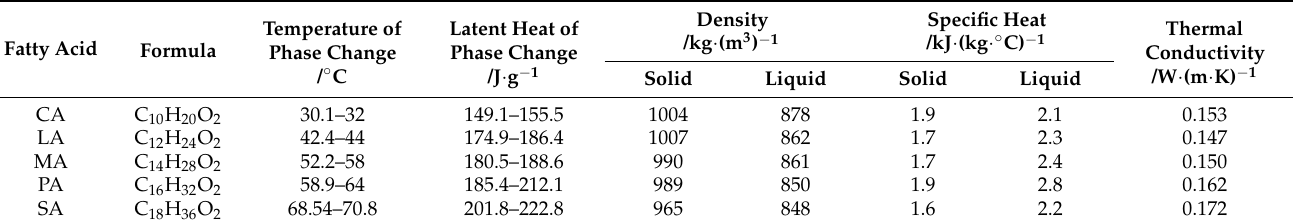
Table 1. Physical characteristics of saturated fatty acids commonly used as